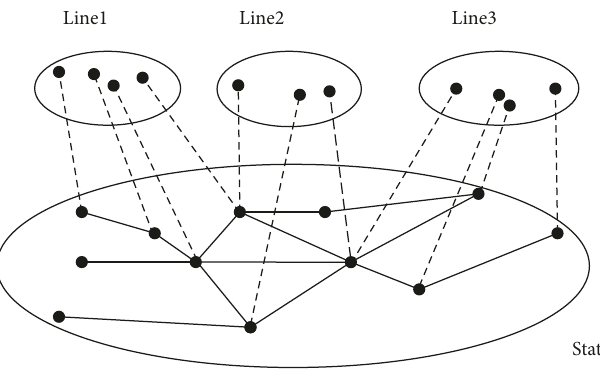
Figure 3: Supernetwork topology map of Nanjing